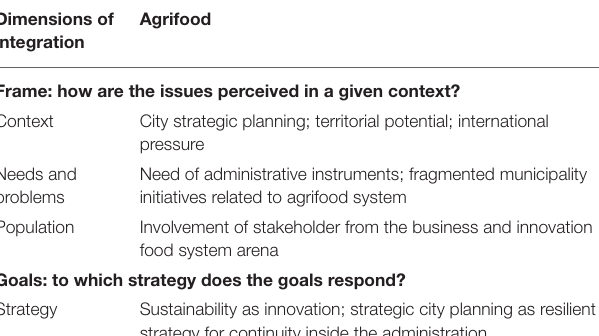
TABLE 4 | Summary of Agrifood process through framework (source: authors). Dimensions of